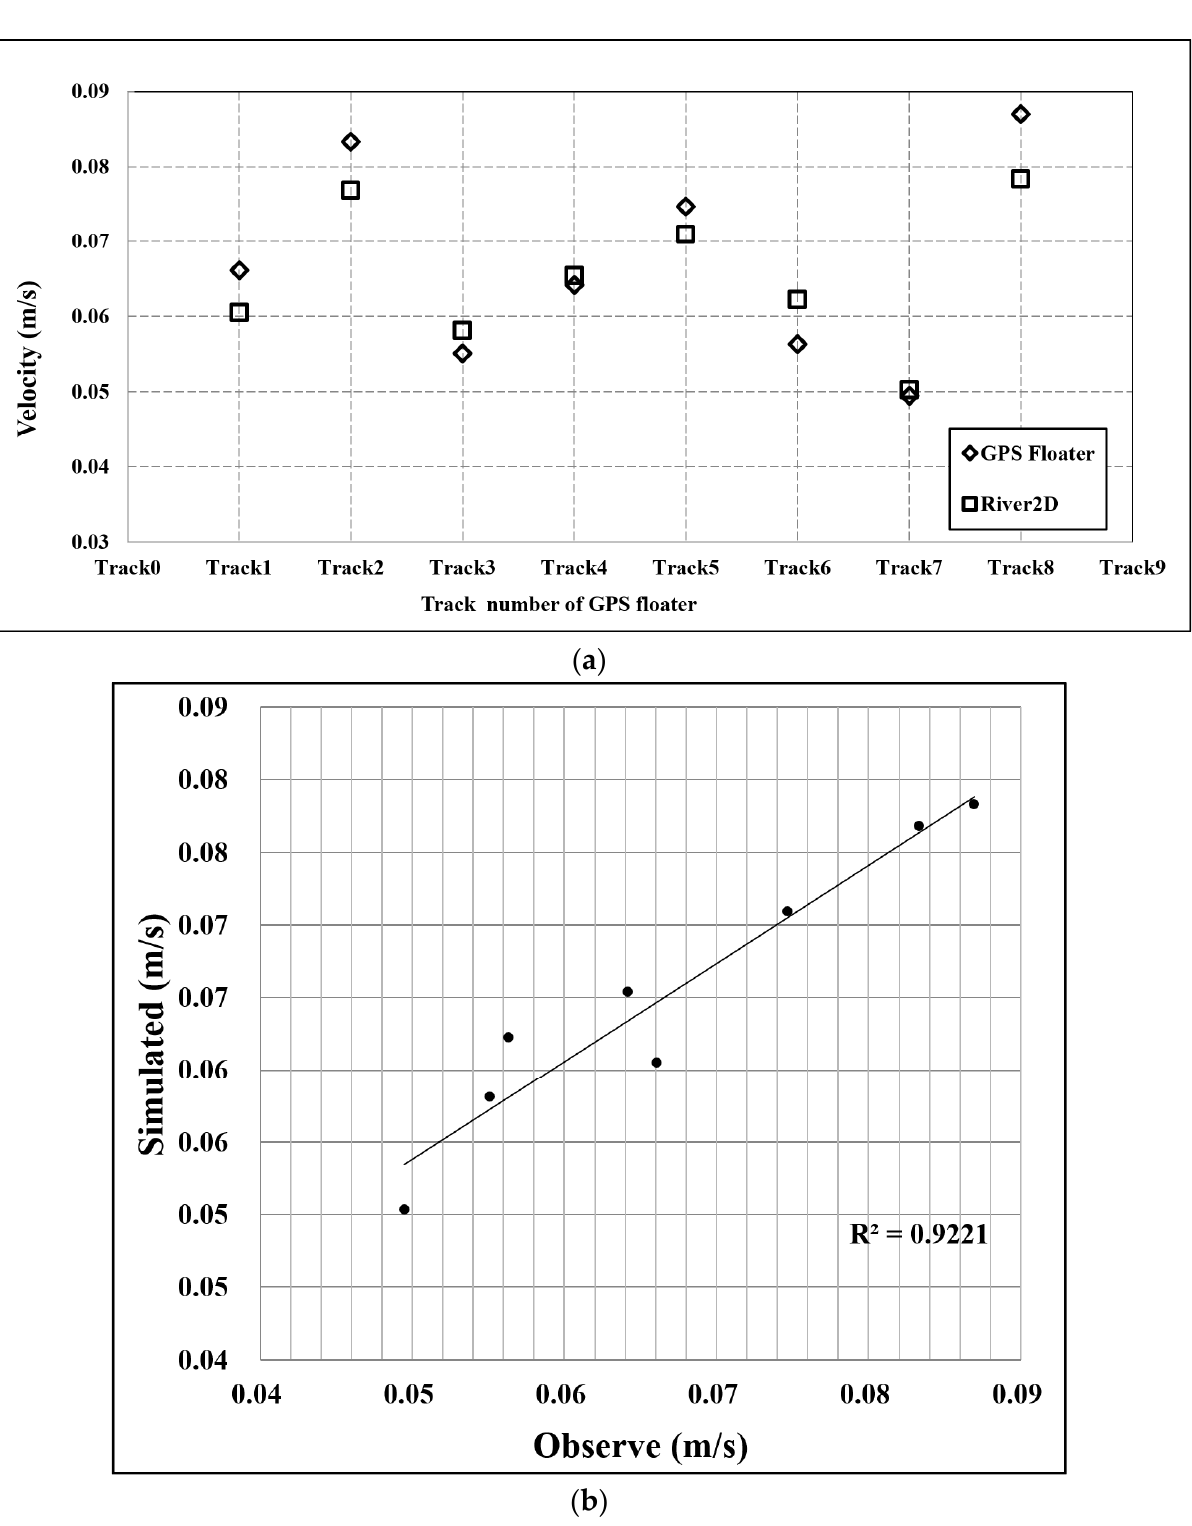
Figure 6. Water velocities (m/s) in fishway of Gangjeong-Goryeong Weir determined by GPS drifter field experiments compared to those calculated by River2D-model for the same eight situations (Track 1 to Track 8): ( a ) presentation of the results—ordinate, velocity (m/s); ( b ) correlation analysis of observed and calculated velocities—abscissa, observed velocity (m/s).